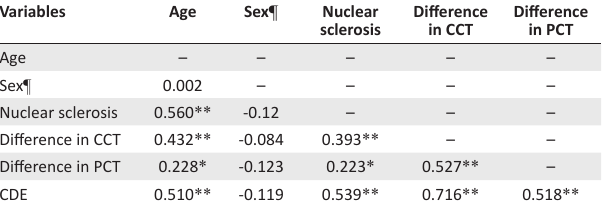
TABLE 7: Correlations between age, sex, type of cataract, pre- and post-operative differences in central and peripheral corneal thickness and cumulative dissipated energy in both study groups.